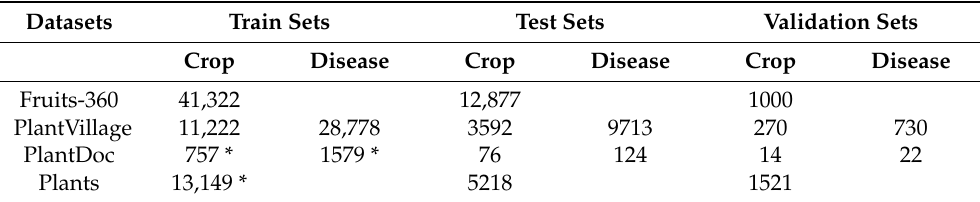
Plants 13,149 * 5218